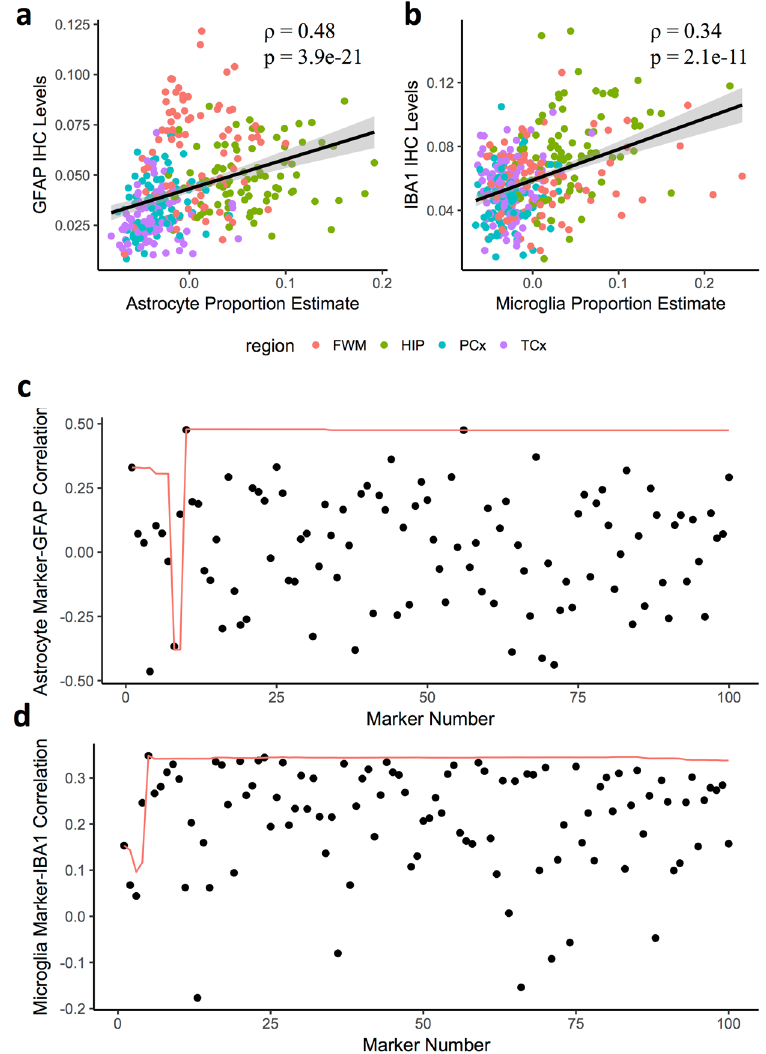
Figure 6. Cell type relative proportion estimates from bulk RNA expression for astrocytes and microglia are associated with IHC quantifications from the Allen Brain Atlas brain bank. (a-b) Scatter plots of the relative cell type proportion estimates, generated using a singular value decomposition (SVD) of the top 50 marker genes for astrocytes ( a ) or microglia ( b ) (x-axis) with the immunohistochemistry (IHC) protein level quantifications for the astrocyte marker GFAP ( a ) or the microglia IBA1 ( b ) (y-axis) in the same donors across the four brain regions in the Allen Brain Atlas Aging, Dementia, and TBI data set. The black line is a result of a linear model fit to the data, while the grey lines represent 95% confidence intervals. ( c , d ) Rho values resulting from rank correlations of the RNA expression of the top 100 marker genes individually (black dots) as well as the SVD-based estimate using the cumulative astrocyte ( c ) or microglia ( d ) marker genes up to that marker gene, inclusive (red lines), with the IHC quantifications for GFAP ( c ) or IBA1 ( d ). FWM, frontal white matter; HIP, hippocampus; PCx, parietal cortex; TCx, temporal